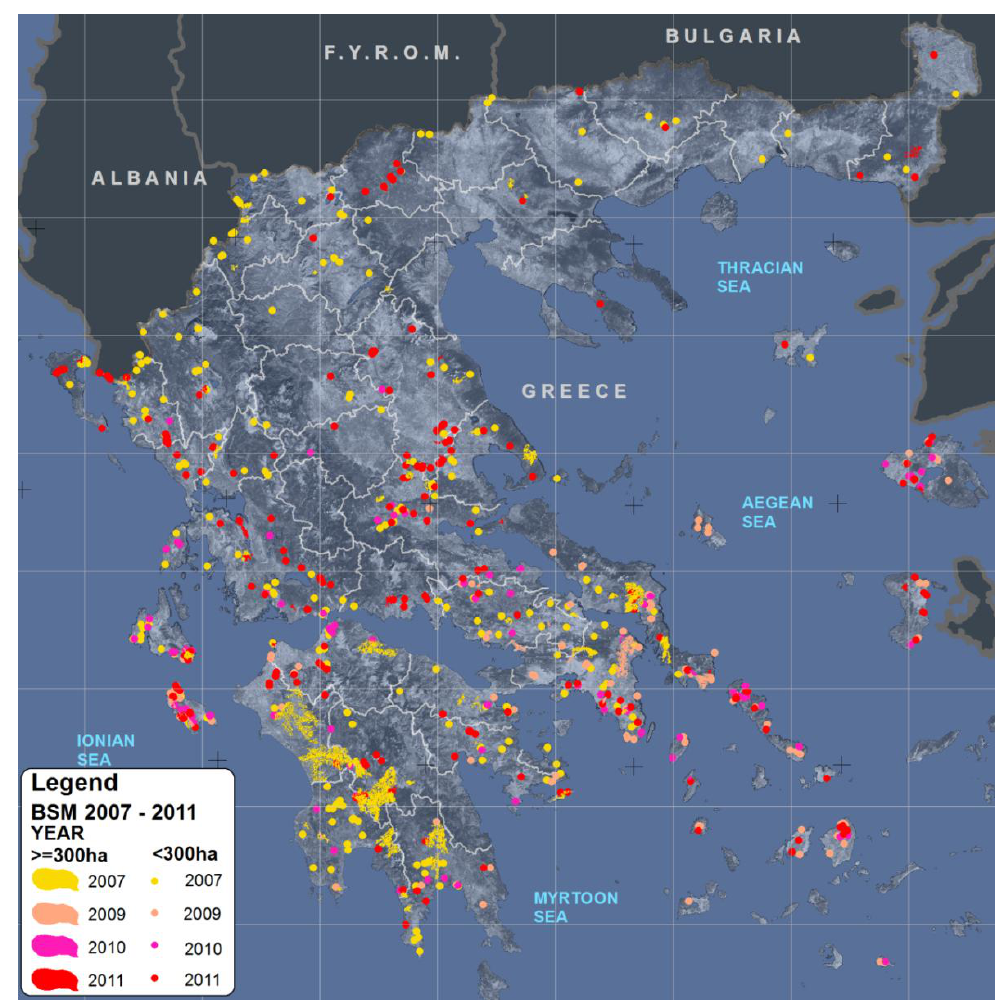
Figure 3. Mapping of burnt areas for the service years 2007–2011. Colored polygons corresponding to burnt areas ≥300 ha, and dots to burnt areas <300 ha, indicate the locations and therefore the geographic distribution of the fire events.